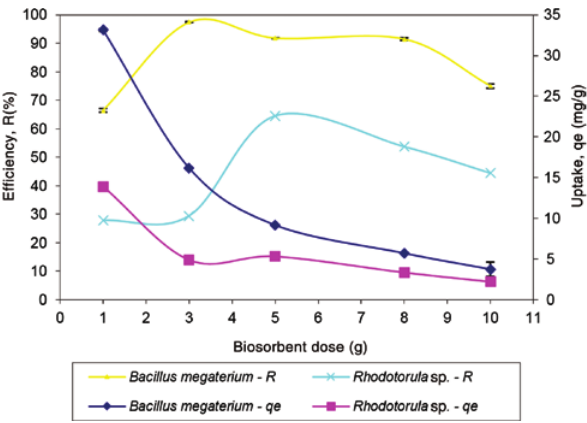
Figure 2: Influence of biosorbent dosage on biosorption of Cd(II) ions by Rhodotorula sp. (pH 6, temperature 25 ° C, contact time 48 h, initial Cd(II) concentration 50 mg/l) and B. megaterium (pH 4, temperature 25 ° C, contact time 48 h, initial Cd(II) concentration 50 mg/l).